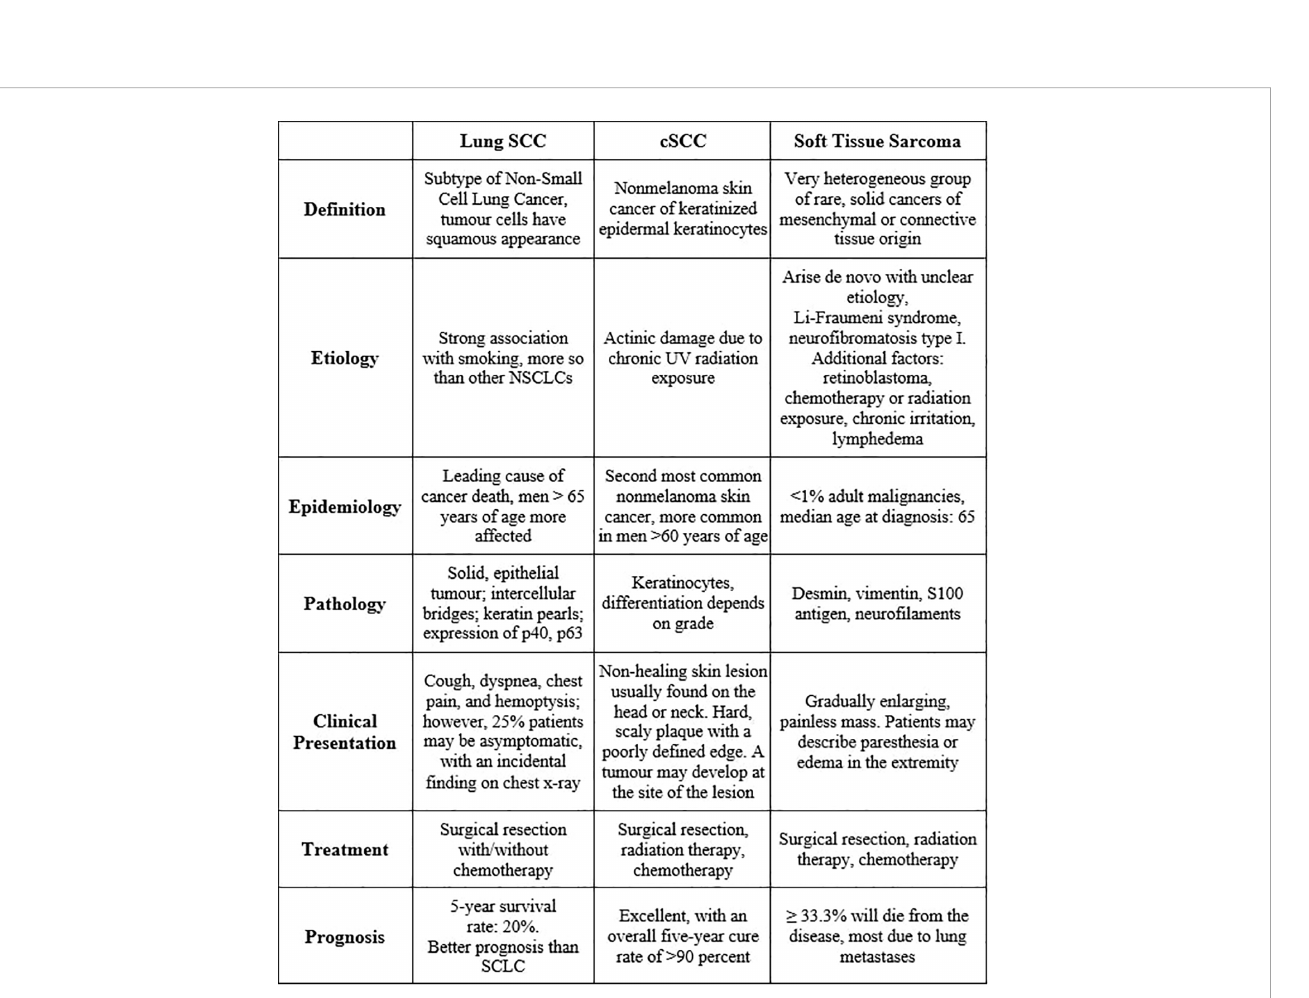
FIGURE 4 Comparison of SCC of the lung, cutaneous SCC, and soft tissue sarcoma.